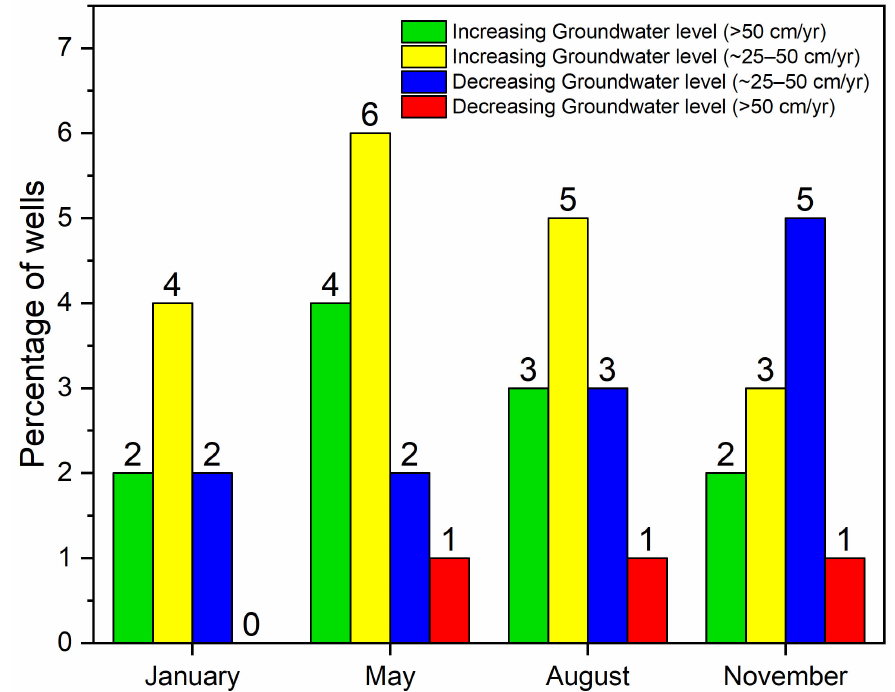
Figure 5. Percentage of wells in the seven cities with extreme (high magnitude) groundwater level trends for January, May, August, and November. About more than 5% and 2% of the wells in the selected cities have extreme increasing and decreasing GWL trends respectively, from January to